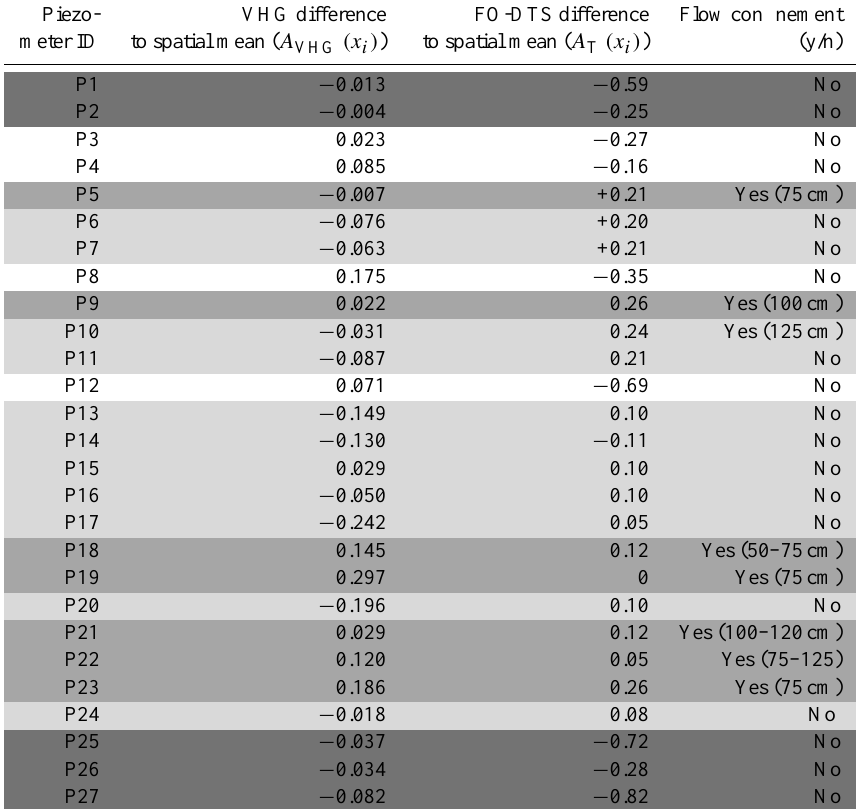
Table 2. Average differences to spatial mean in VHG and FO-DTS monitored streambed temperatures (in direct vicinity to piezometer VHG observations) over the entire VHG and FO-DTS survey period in comparison to streambed structural information of up-welling